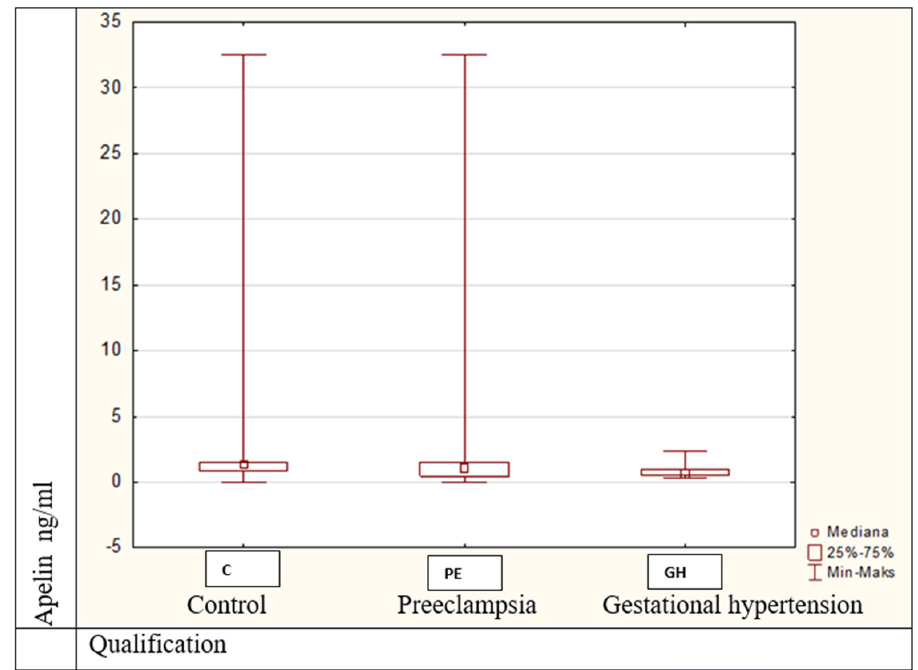
Figure 4 Figure 4. Apelin values between pregnant women in all groups, p =